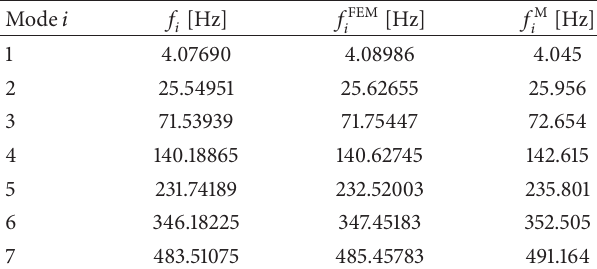
Table 9: Natural frequencies of the uniform beam.